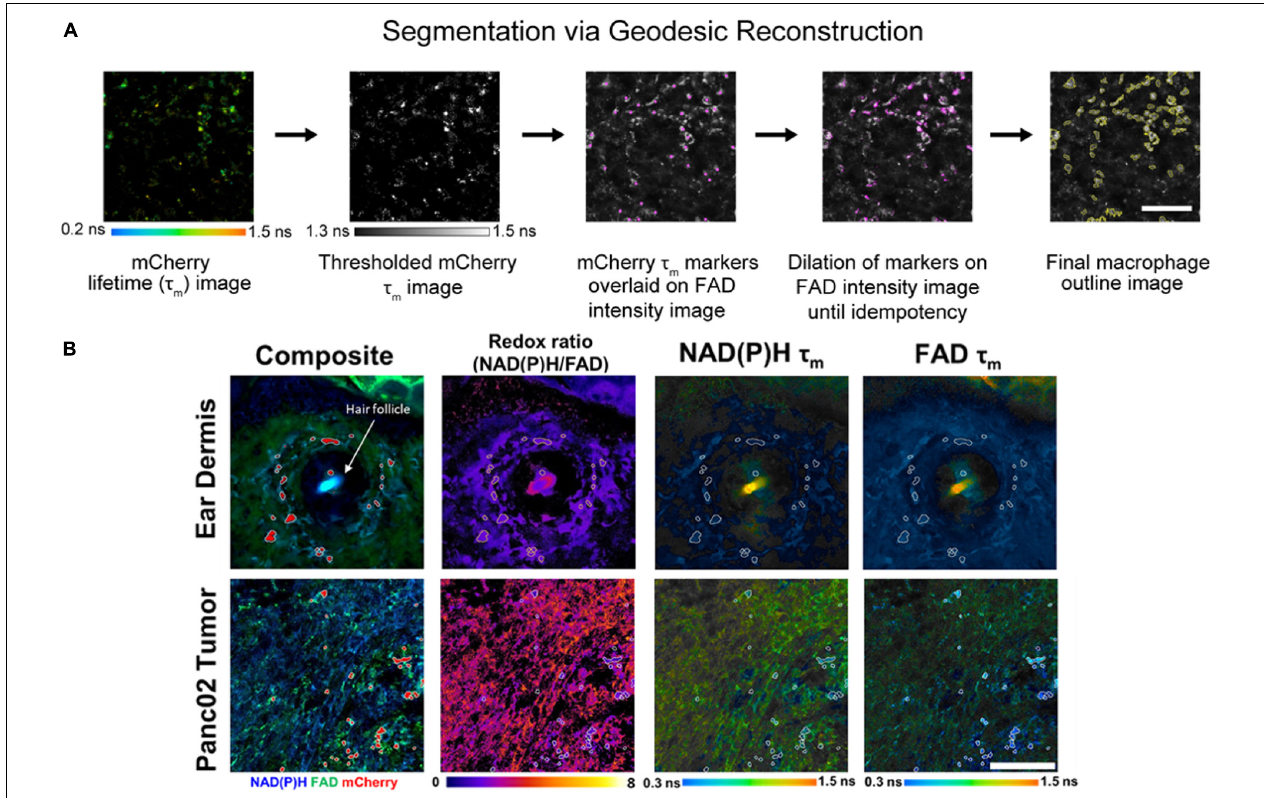
FIGURE 2 | In vivo metabolic autofluorescence imaging and segmentation of macrophages in tumor and dermal tissue. (A) Geodesic reconstruction for segmenting mCherry+ macrophages. Lifetime images of mCherry were thresholded [1.3–1.5 ns, based on reported mCherry lifetime values (Gu et al., 2013; Penjweini et al., 2018; Štefl et al., 2020)] to exclude any non-specific fluorescence in the red emission channel. Thresholded images were used as a marker image to identify mCherry+ cells. FAD intensity images were used as mask images based on previous evidence of high FAD intensity in macrophages (Szulczewski et al., 2016). The marker image was overlaid on the mask image and iteratively dilated until all connected component objects in the mask image were intersected (idempotency). Cell outlines were then determined from the reconstructed masks. Scale bar = 125 µ m. (B) Representative fluorescence images of mouse ear dermis and Panc02 pancreatic tumors. Composite intensity images visualize tissue-infiltrating macrophages (mCherry, red) with co-localized NAD(P)H (blue) and FAD (green) autofluorescence. Autofluorescence intensity and lifetime images demonstrate qualitative differences in the optical redox ratio [intensity of NAD(P)H divided